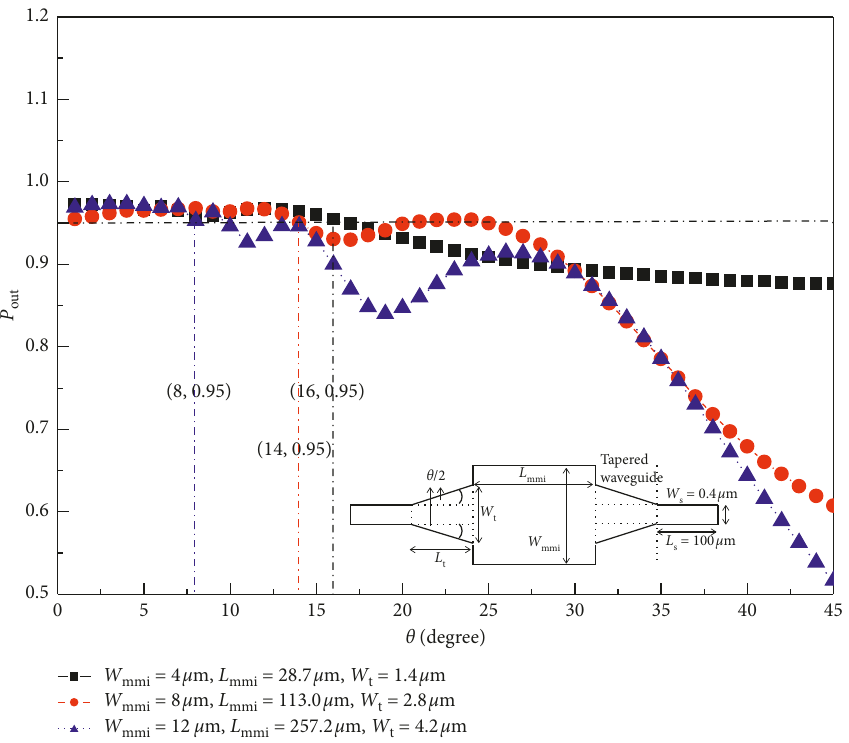
Figure 8: When W × 1 MMI coupler with W � 4 μ m/8 μ m/12 μ m achieves a minimum width of linear tapered t / W mmi is set at 0.35, the 1 mmi waveguide at W t � 1.4 μ m/2.8 μ m/4.2 μ m, respectively. As the divergence angle θ of a linear tapered waveguide is scanning the range from 1 ° to 45 ° at a step of 1 ° , a maximum divergence angle θ � 16 ° /14 ° /8 ° is obtained under the constraint of P ≥ 0.95, out